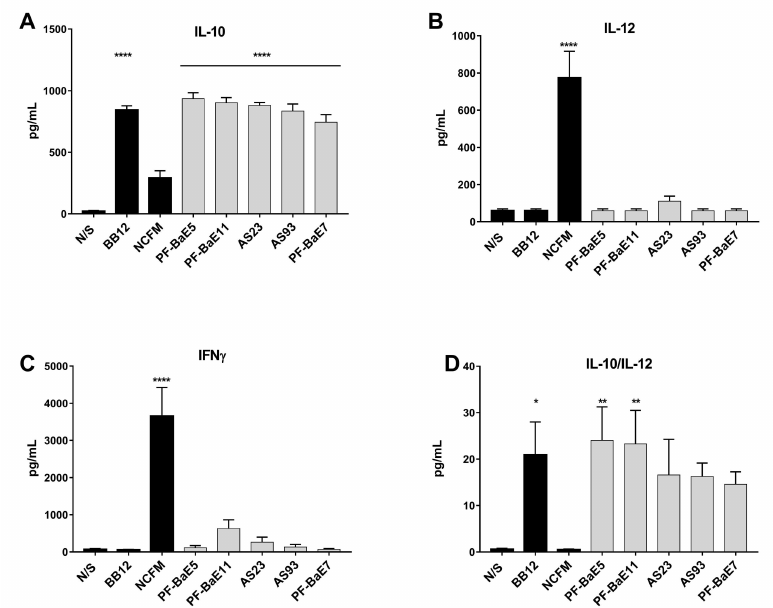
Figure 2. In vitro immunomodulatory profiles of the strains. ( A ) IL-10, ( B ) IL-12p70 and ( C ) IFN- γ production was evaluated in the supernatants of peripheral blood mononuclear cells (PBMCs; n = 5 di ff erent donors) stimulated for 24 h by the tested strains or two control strains ( L. acidophilus NCFM and B. animalis subsp. lactis BB12), in comparison to non-treated cells (N / S). ( D ) IL-10 / IL-12 ratio was calculated. Data represent means ± SEM of the 5 independent donors. * refers to the comparison of bacteria-stimulated PBMCs versus untreated cells; * p < 0.05, ** p < 0.01, **** p <